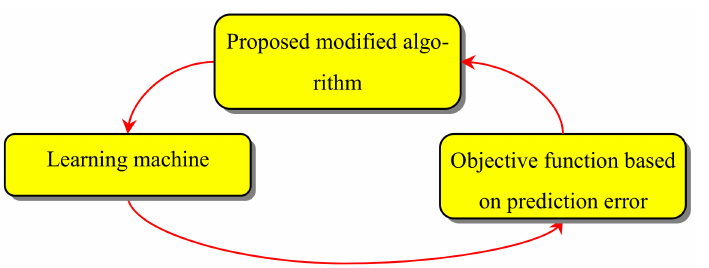
Figure 7. A typical overview of relation between GWO and learning method in order to decrease the prediction error.